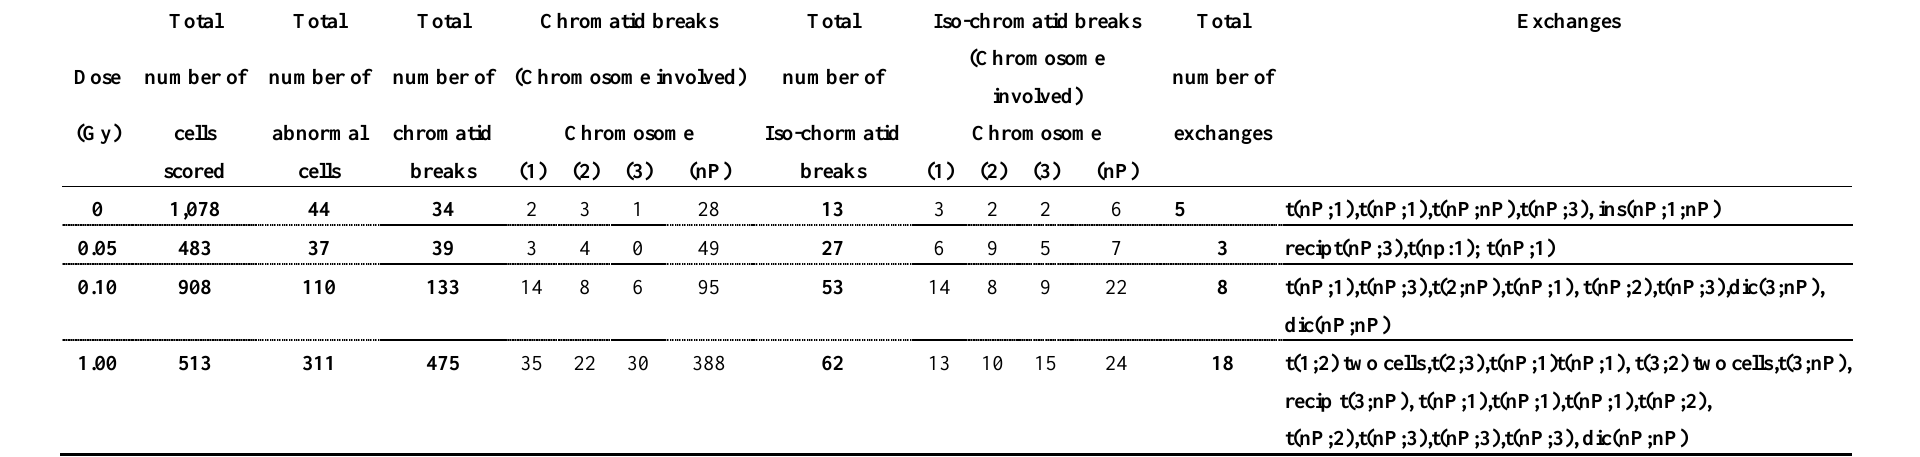
Table 1. Cytogenetic data from bone marrow cells collected at 1 h after exposure of male SCID/J mice to varying low doses of 137 Cs  rays, including a high dose of 1.0 Gy serving as a reference dose. All aberrations are chromatid-types. Total Total Total Chromatid breaks Total Dose number of number of number of (Chromosome involved)